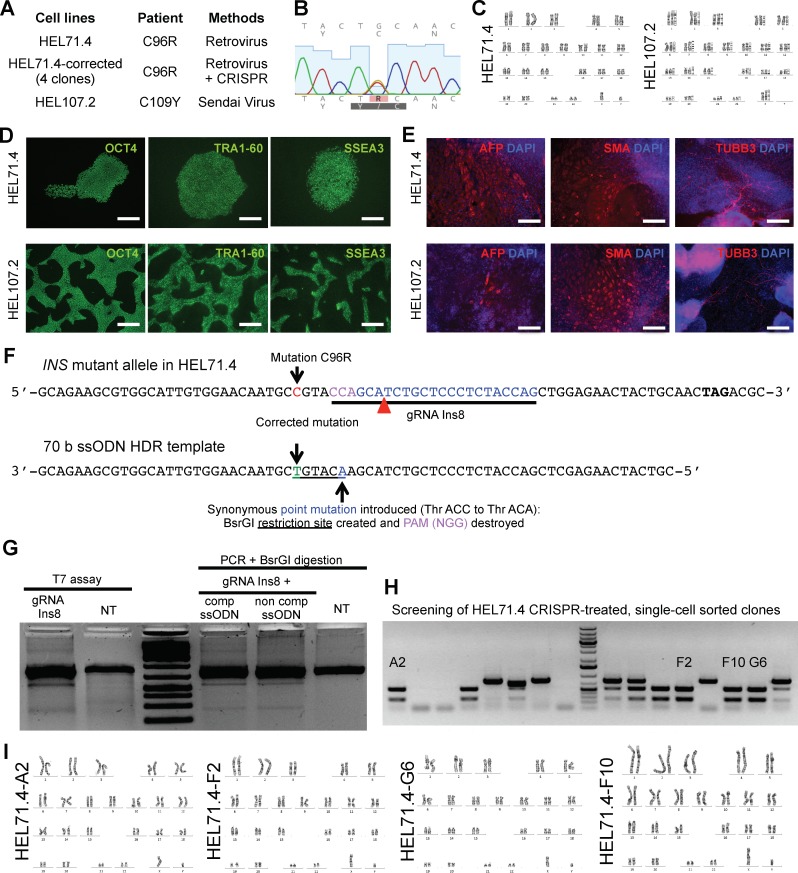
iPSC lines characterization and correction of INS C96R mutation.(A) Table of cell lines generated from people carrying insulin gene mutations. (B) Sequencing of C109Y G to A heterozygous mutation in HEL107.2 cell line. (C) Normal 46XY and 46XX karyotypes of the derived iPSC lines. (D) Immunocytochemistry for pluripotency markers. Scale bars = 500 μm. (E) Immunocytochemistry for markers of different germ layers in embryoid-body differentiated iPSC lines. AFP, alphafetoprotein (endoderm); SMA, smooth muscle actin (mesoderm); TUBB3, tubulin beta-3 (ectoderm). Scale bars = 200 μm. (F) Schematic representation of gRNA targeting the INSC96R mutation and the 70 b donor template used for the CRISPR-SpCas9-stimulated homology directed repair (HDR) correction. (G) Cutting efficiency of gRNA Ins8 and recombination efficiency of ssODNs repair templates complementary and non complementary to gRNA Ins8 in HEK293 cells. (H) Screening of corrected clones. BsrGI restriction of PCR amplicons coming from different HEL71.4, CRISPR-treated, single cell-sorted clones. Recombinant clones A2, F2, F10 and G6 were verified as corrected by Sanger sequencing (Figure 1c). (I) Normal 46XY karyotypes of HEL71.4 corrected clones.